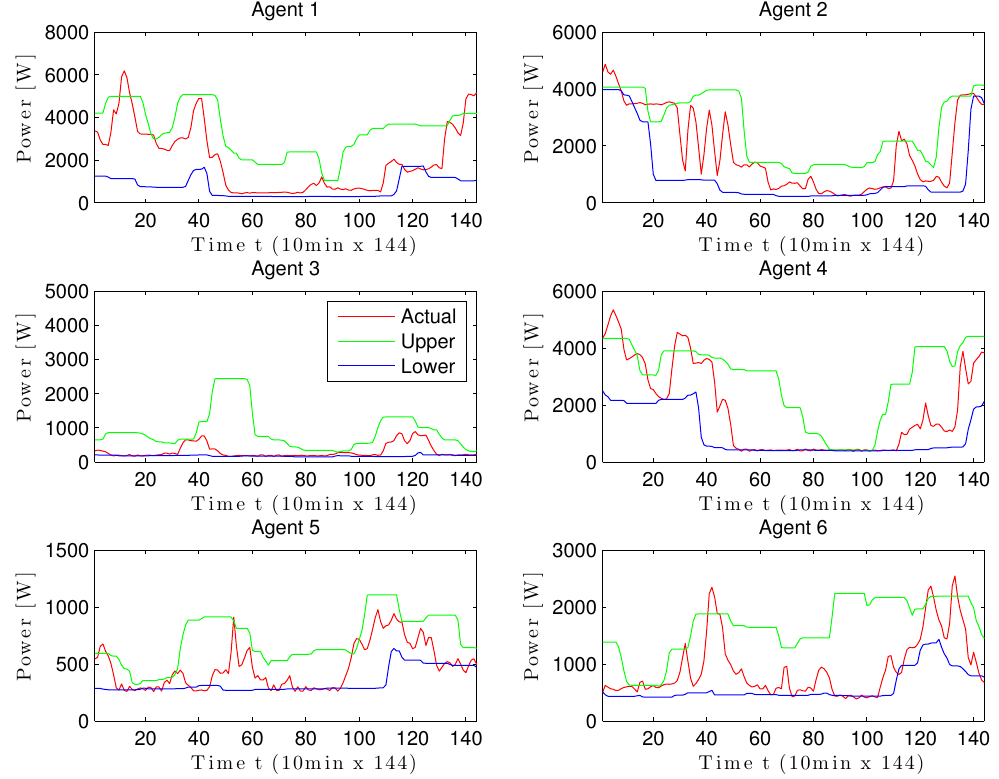
Figure 12. Actual consumption and estimated fluctuation range (“upper” and “lower” in the figure) for 6 out of the 37 households used in the experiments. Note that the figures have different scales. See main text for details on the estimation of fluctuation